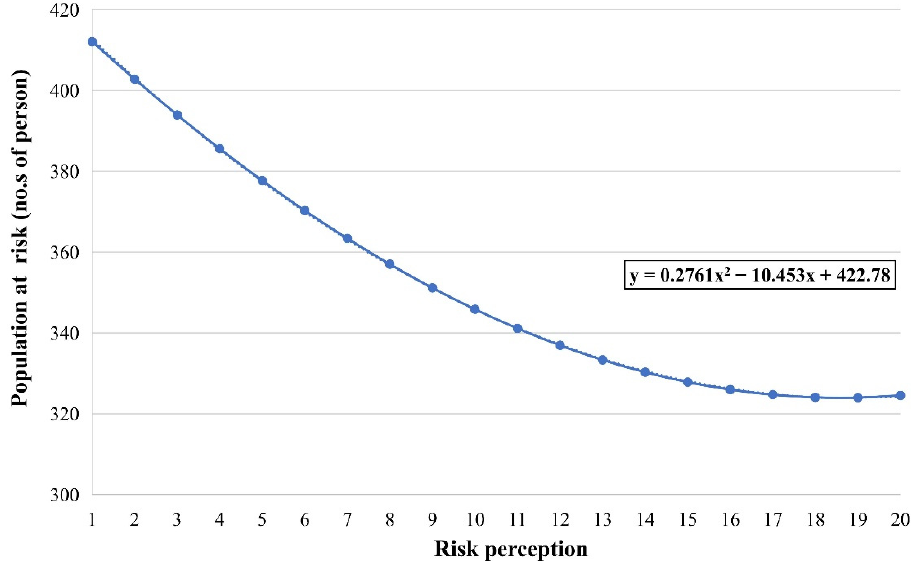
Figure 10. Correlation between risk perception and the population at risk.